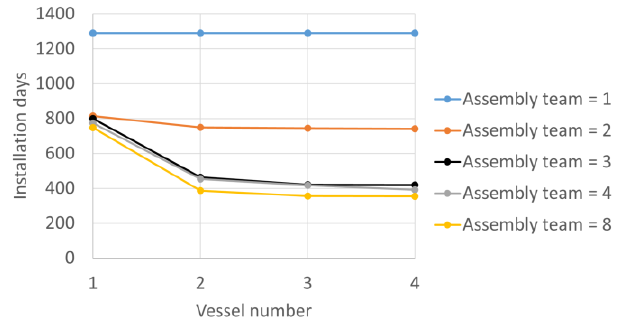
Fig. 11. Installation time against number of vessels for various numbers of assembly teams, in the case of c/d time 1 hr.